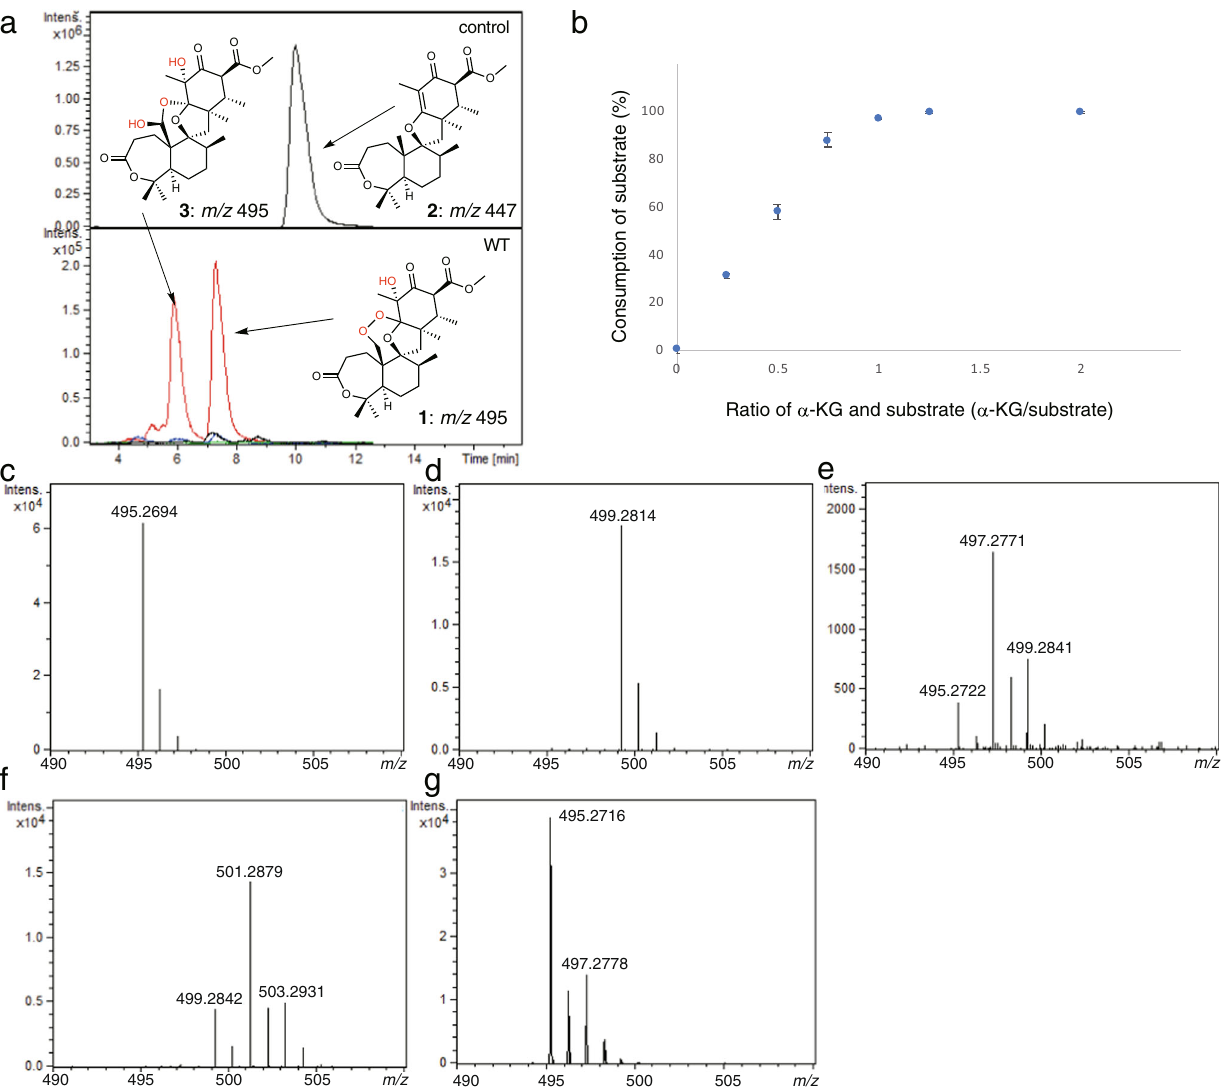
Fig. 2 Enzyme reactions of NvfI. a In vitro enzyme reaction of NvfI with 2 . b Consumption of 2 in the enzyme reactions of NvfI, using varied ratios of 2 and α -KG. c – f The 18 O 18 O-labeling experiment. The enzyme reactions containing ( c ) 16 O 2 and H 2 18 O 18 O. g Overnight incubation of 1 in H 18 O-containing buffer. All experiments were repeated independently more than three times with similar 2 and H 2 2 results. The blue dots are means of n = 3 independent experiments and error bars indicate standard